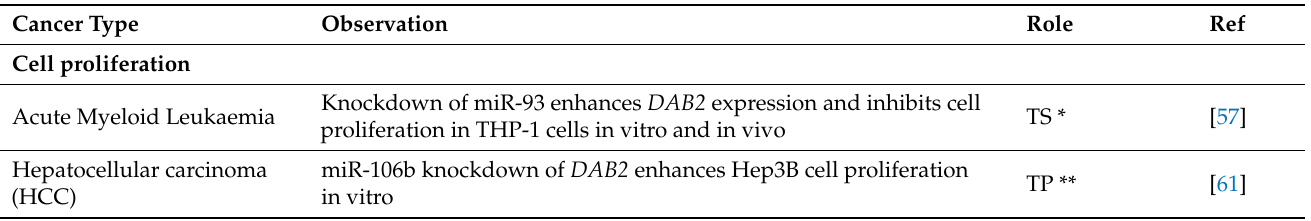
Table 2. The functional roles of DAB2 in